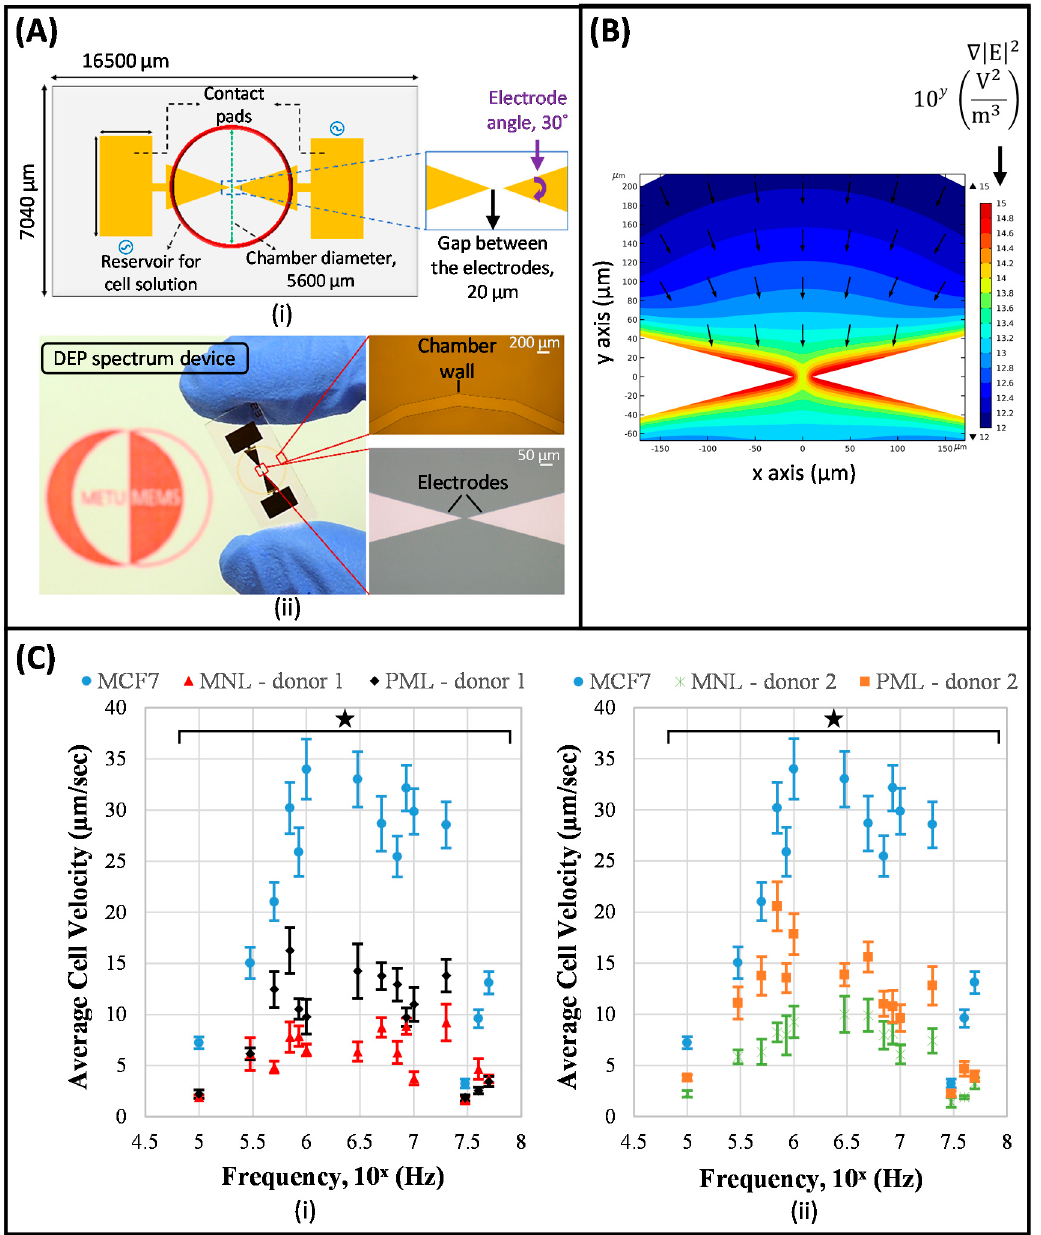
Figure 3. ( A ) The schematic illustration ( i ), and the photograph ( ii ) of the dielectrophoresis (DEP) spectrum device. ( B ) Simulation results presenting the direction and distribution of the generated electric field gradient on the device (due to the symmetry, only the first two quadrants are shown). ( C ) DEP spectra of MCF7 cells, polymorphonuclear and mononuclear leukocytes of two donors. ( i ) DEP spectra of MCF7 cells and leukocytes of donor 1: 32-year-old woman. ( ii ) DEP spectra of MCF7 cells and leukocytes of donor 2: 39-year-old woman. Mean values (symbols) and standard error of the means (error bars) are plotted for each examined frequency. Statistical significance ( (cid:70) p < 0.05) between the MCF7 cells and leukocytes is represented for the examined frequency range [175]. Copyright 2020, John Wiley and